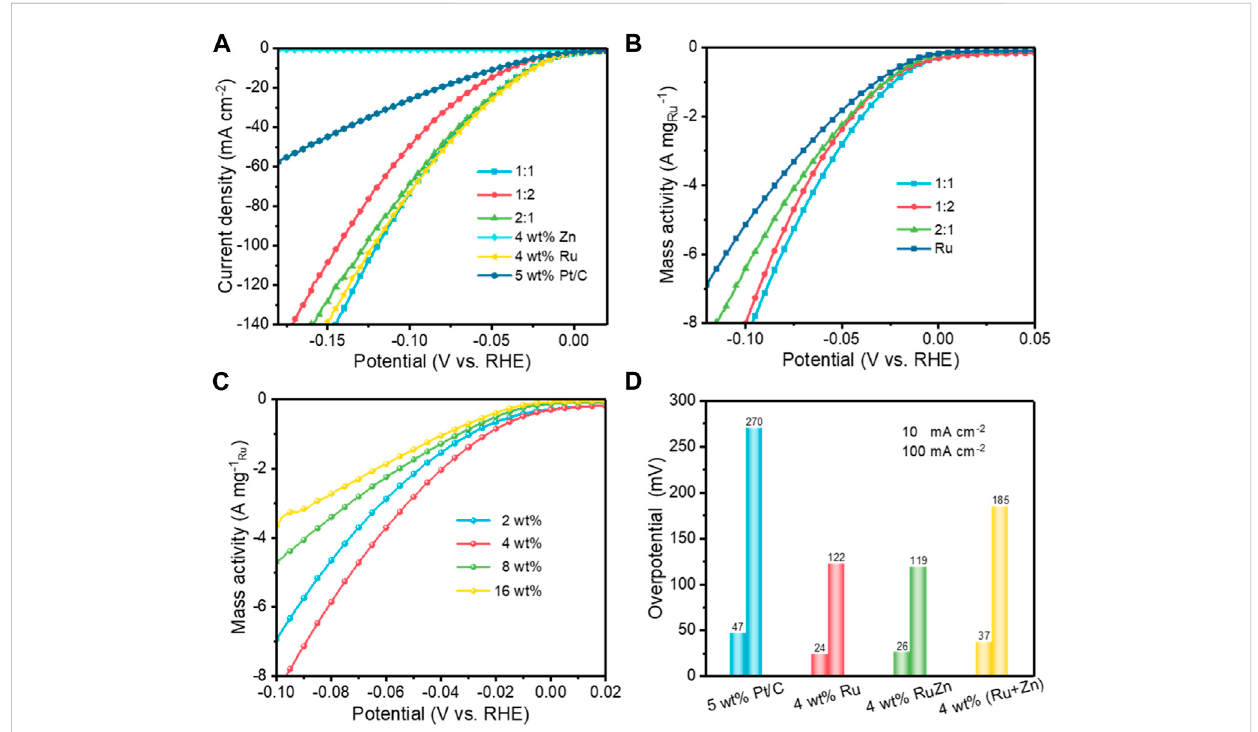
FIGURE 2 TheelectrocatalyticHERperformancesofthedifferentRu-basedcatalystsin1 MKOH. (A) Polarizationcurvesof4 wt%Ru-Zn/MWCNTscatalystsat different Ru:Zn molar ratios with 90% iR correction; (B) The mass activity normalized by the amounts of Ru in the 4 wt% Ru-Zn/MWCNTs catalysts at different Ru:Zn molar ratios; (C) The mass activity of the x wt% Ru-Zn/MWCNTs catalysts with different total loadings of Ruand Zn at a Ru: Zn molar ratio of 1:1; (D) Overpotential comparison of the different Ru- and Zn-based catalysts at the current intensities of 10 and 100 mA cm − 2